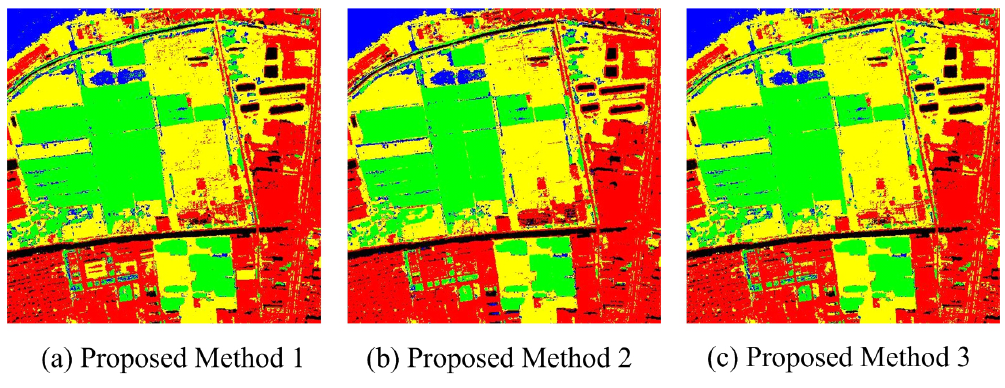
Figure 10. Classification results based on proposed concatenation combination